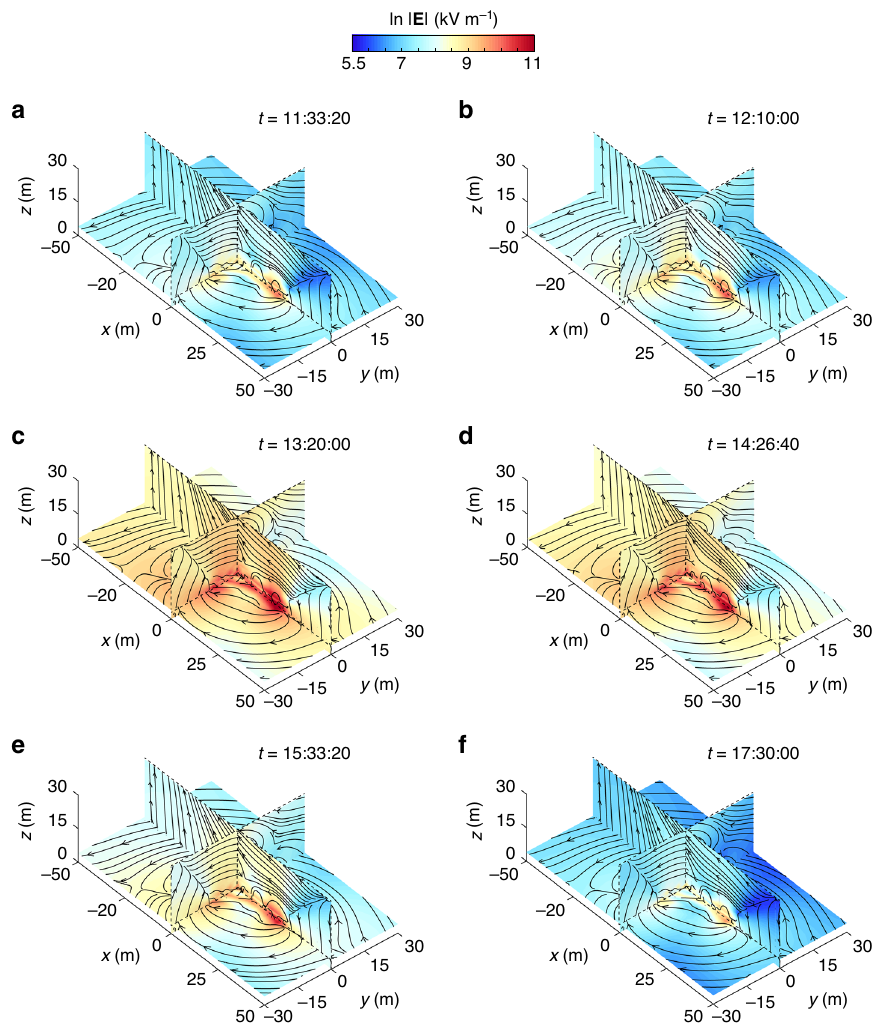
Fig. 6 Evolution of the 3D structure of the E- fi elds during storm #1. a – f E- fi eld predicted from the reconstructed space-charge densities at different stages of the observed storm. Slices at x = 0 m, y = 0 m, and z = 4 m are colored based on the log-magnitude of the 3D E- fi eld, ln j E j . Times t are shown as the local time on April 16, 2017 (UTC + 8). Lines represent the E- fi eld